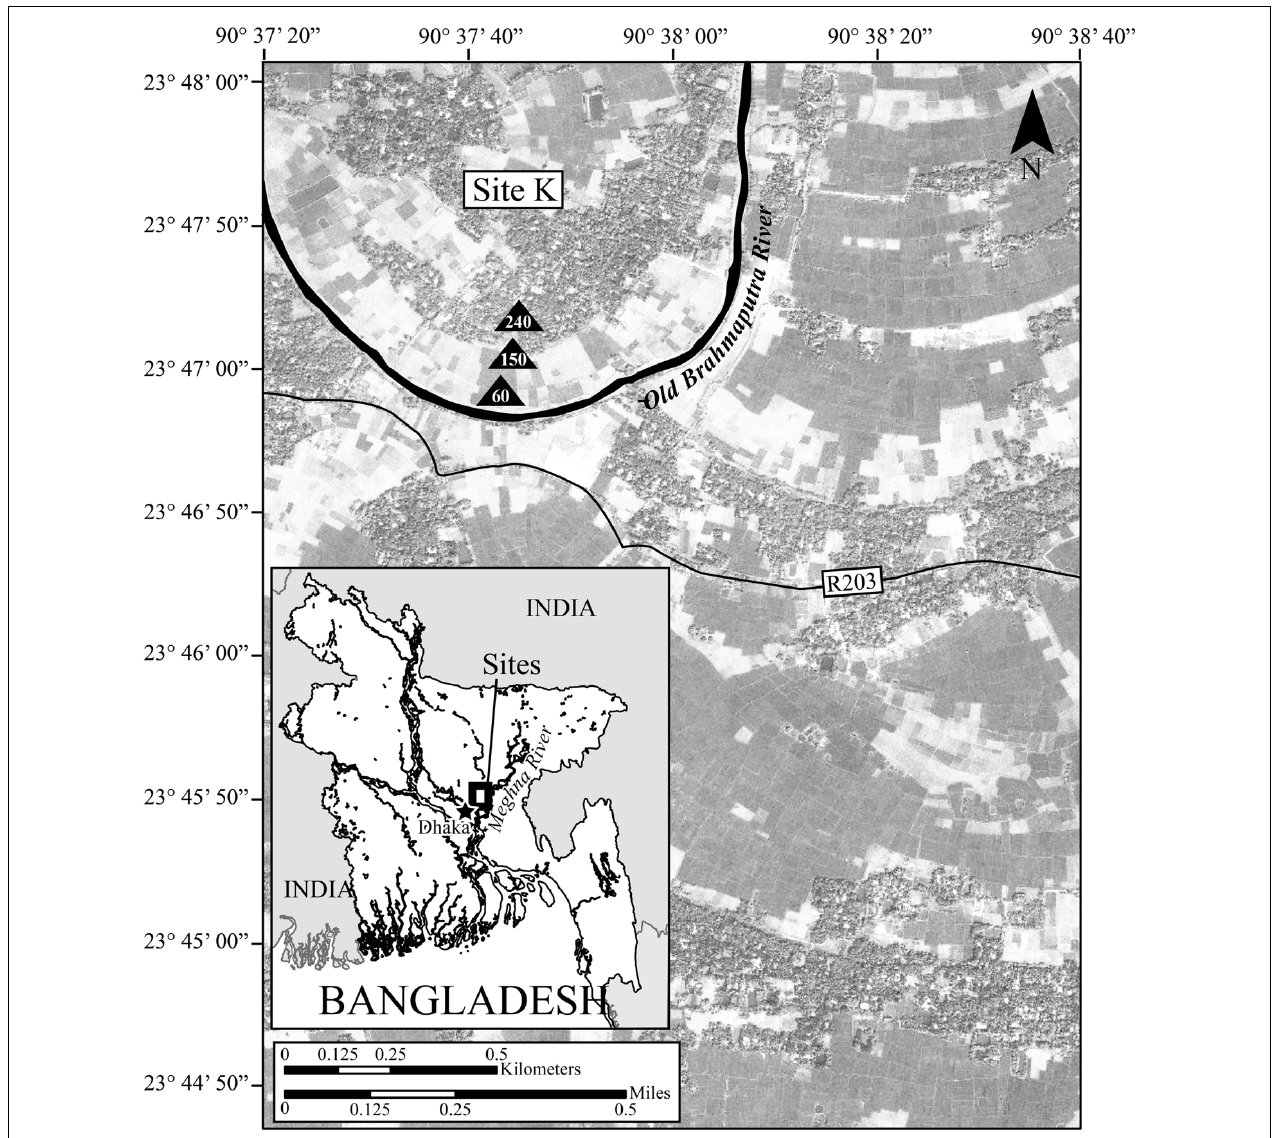
FIGURE 1 |The study area, Site K, inAraihazar,